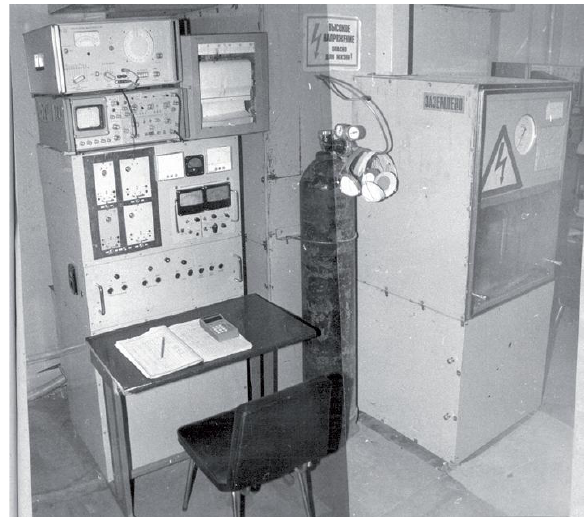
Figure 11. An electric pulse sintering